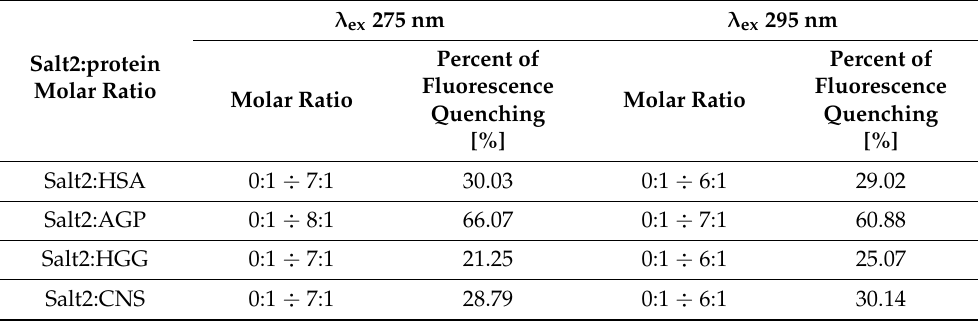
Table 1. Percentage [%] of fluorescence quenching of HSA, AGP, HGG and CNS in the presence of Salt2 with increasing concentration at excitation wavelenght λ ex 275 nm and λ ex 295